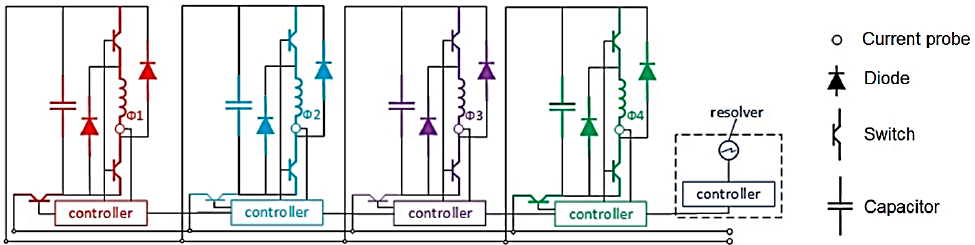
Figure 5. SRM Power Control Unit diagram.